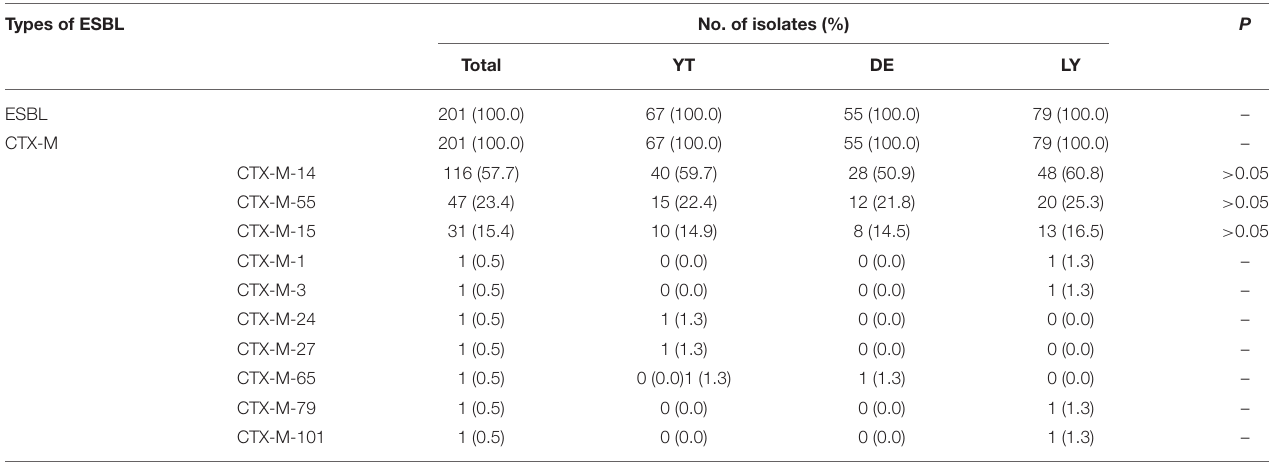
TABLE 2 | ESBL genes in 201 ESBL-positive E. coli isolates from three administrative districts. Types of